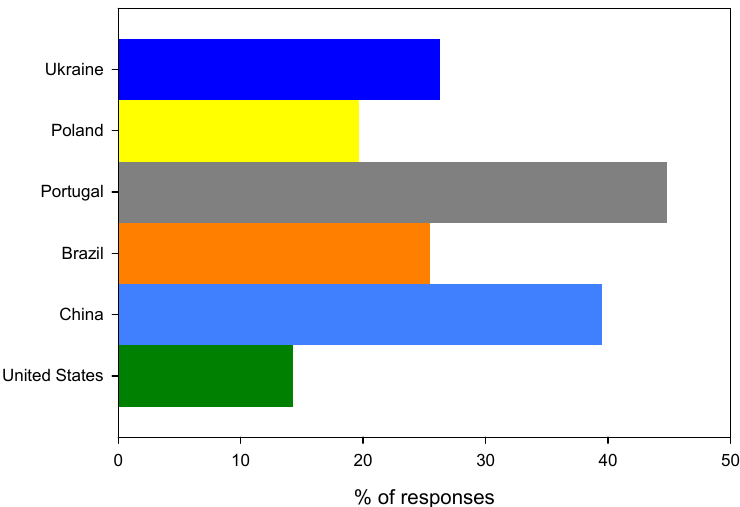
Figure 9. The distribution of positive answers to the question: Did you know that bioplastic can extend the life of a product and preserve its visual and taste properties?